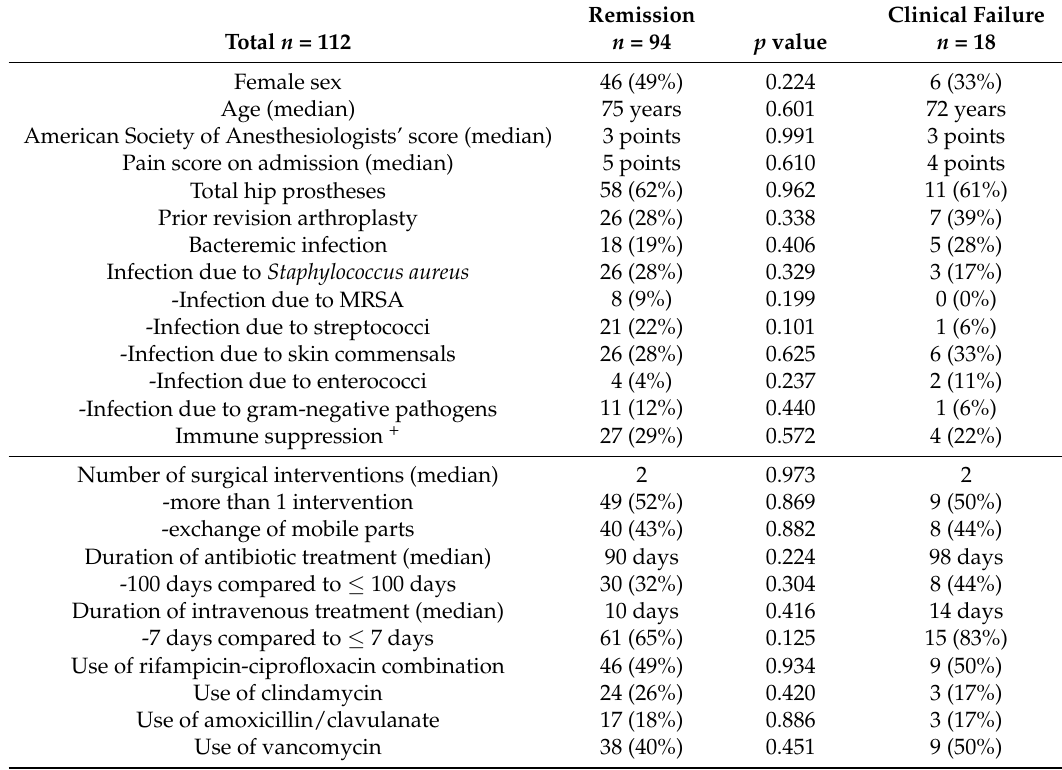
Table 1. Comparison of demographic, clinical, and treatment characteristics of patients with the debridement and retention of the implant (DAIR) approach for prosthetic joint infections (PJI).